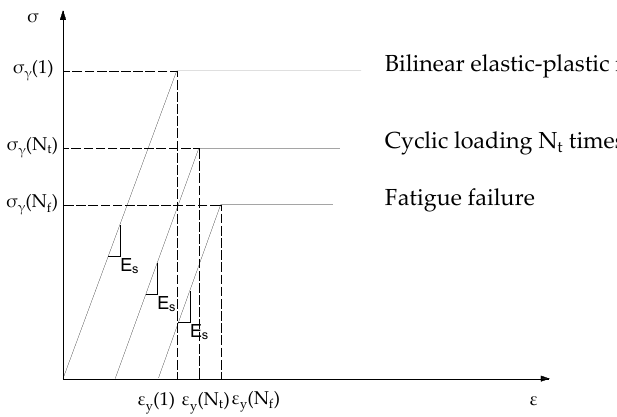
Figure 11. The constitutive model of the steel bar under fatigue damage.